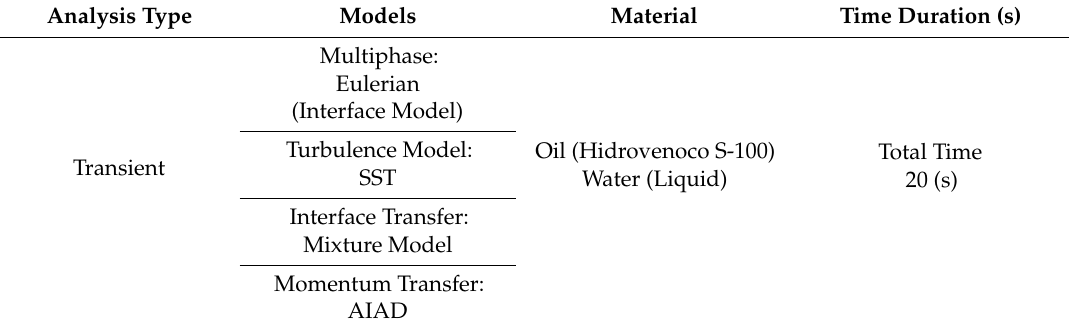
Table 4. CFX input deck.